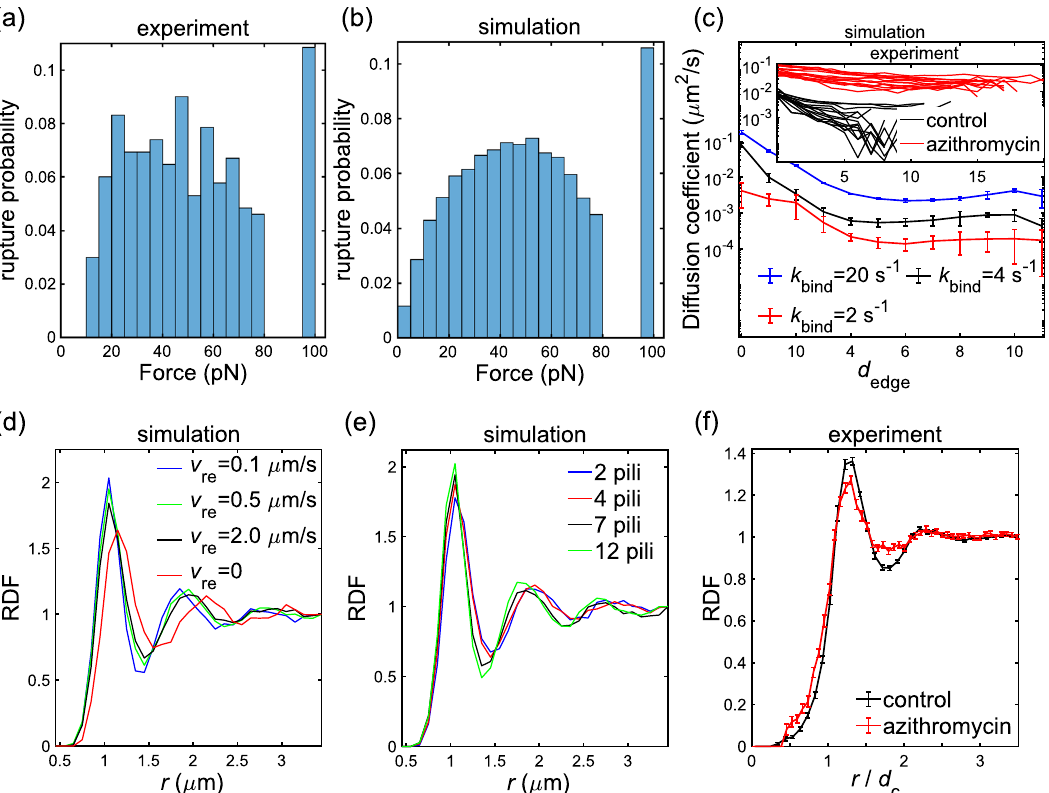
Fig. 3 Pilus-generated forces and local colony order. a Experimental results for the distribution of pilus – pilus bond rupture forces measured with an optical trap 17 . Forces above 80 pN cannot be measured precisely, the histogram bar at 100 pN represents the contribution of all forces over 80 pN. b Distribution of pilus – pilus bond rupture forces in simulations. c Diffusion coef fi cient of bacteria as a function of distance from the colony edge d edge in simulations. Error bars show standard deviations in three samples. Inset: experimental data for wild-type cells and azithromycin-treated cells 47 . d Radial distribution function (RDF) of cells inside simulated colonies for different pilus retraction velocities. The shape of the functions, with decreasing, quasiperiodic maxima resembles the RDF of a liquid. For passive pili ( v re ¼ 0), k bind = 2 s − 1 is used, compare Table 1. e The maxima in the RDF become more pronounced with increasing numbers of pili per cell, thus, pili promote ordering. f Experimentally determined RDF for wild-type cells and azithromycin-treated cells with fewer T4P 47 . The cell diameter d c is 1.02 μ m for the untreated control cells and is 1.42 μ m for the azithromycin-treated cells. Error bars are the standard error of the mean with a sample size of 24